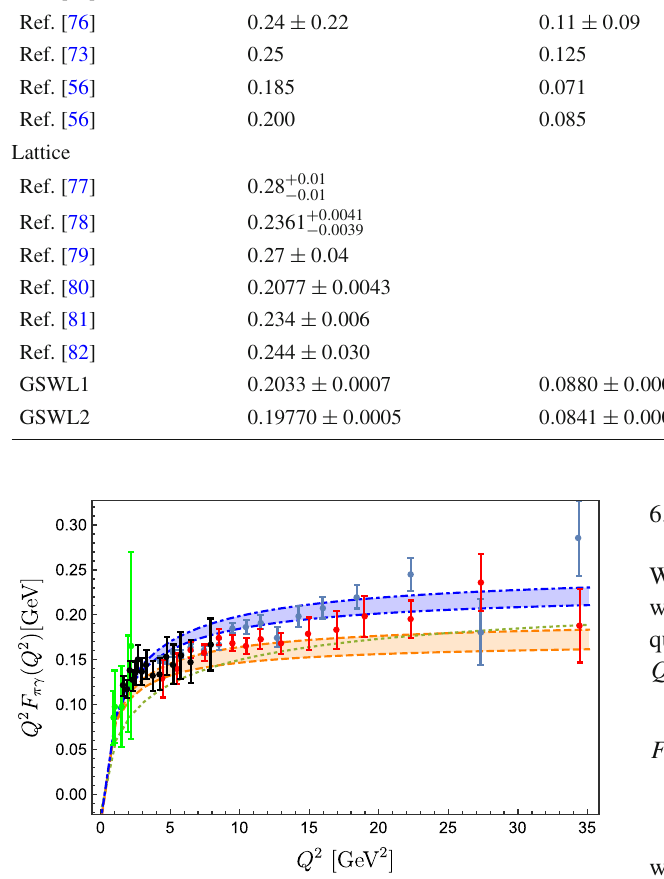
Fig. 6 The pion to photon transition form factor, Eq. (65) evaluated within the GSWL2 (dashed) and GSWL1 (dot-dashed) parametriza- tions. The dotted line stands for the SW prediction. Data are collected = 0 . 07 GeV from Refs. [83–86]. The initial scale is μ 2 0